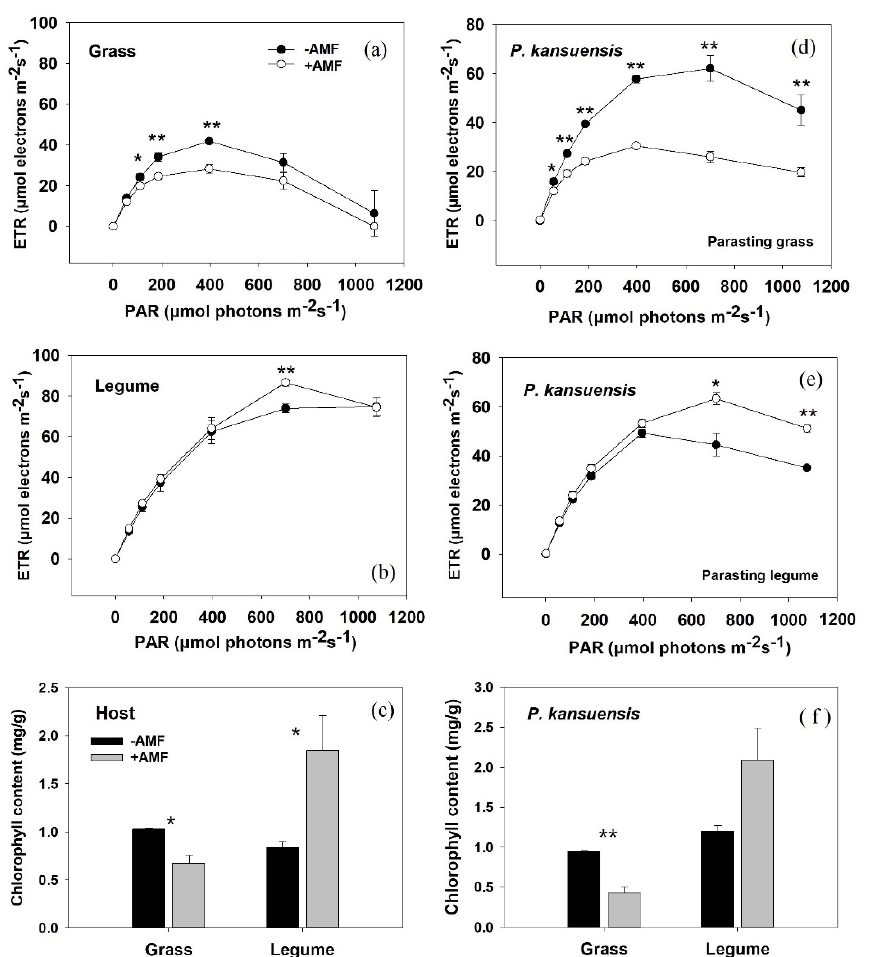
Figure 5. Electron transport rate (ETR) light-response curves and total chlorophyll contents in leaves of Elymus nutans (grass, ( a , c )), Trifolium repens (legume, ( b , c )) and Pedicularis kansuensis ( d – f ). Data are presented as the mean ± standard error of three replicated pots. Significant differences (as determined by t test) between mycorrhizal (gray bars) and nonmycorrhizal (black bars) treatments are indicated by asterisks (* p < 0.05, ** p < 0.01).